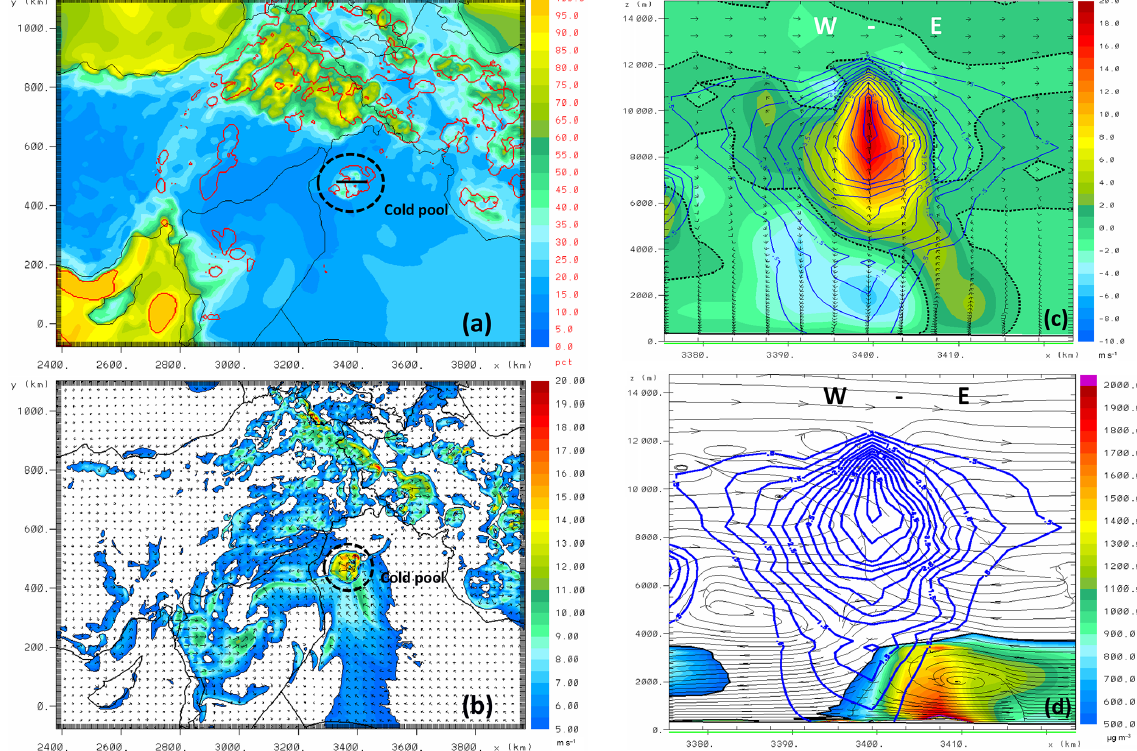
Figure 7. (a) Model relative humidity at the first model level (colour scale) and rain droplet–ambient air difference ( − 20 ◦ C shown by red line contours). (b) Model wind speed at 10m (ms − 1 ). The dashed line denotes the location of the cold pool and the solid black line the location of the storm cross sections of (c) and (d) . (c) Vertical cross section of total condensate mixing ratio (blue contours in gkg − 1 ) and vertical wind component (vectors and colour scale in ms − 1 ). The dashed line separates updraft (positive w ) from downdraft/precipitating regions (negative w ). (d) Vertical cross section of total condensate mixing ratio (blue contours in gkg − 1 ), dust concentration (µgm − 3 ), and flow streamlines on 6 September 2015,